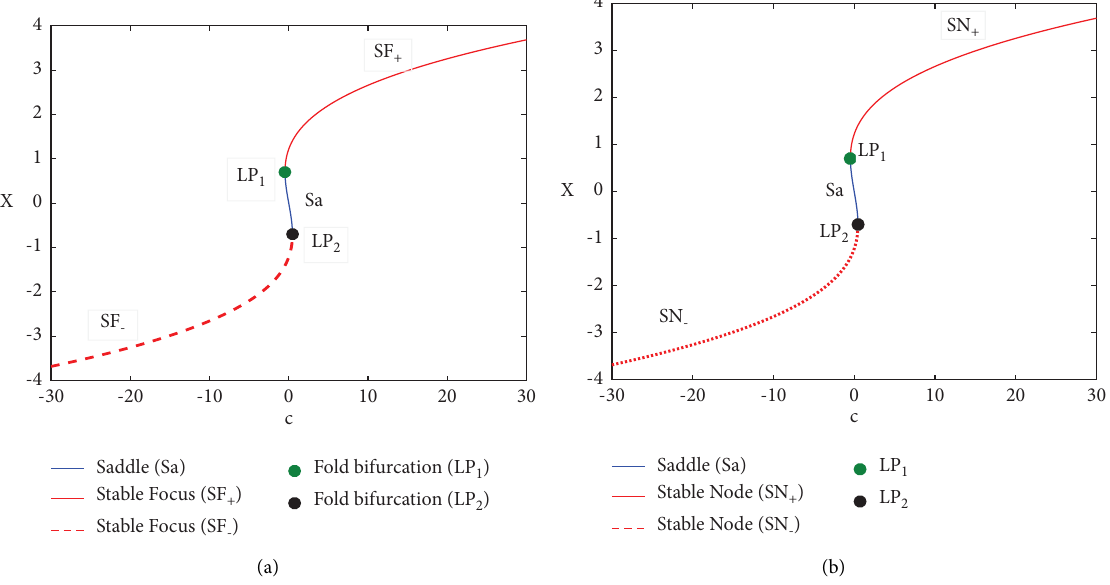
Figure 11: Defection of the plant with respect to c for diferent values of the damping ratio ξ showing the equilibrium points of the plant- wind system for parameters of Figure 7 with (a) ξ � 0 . 5 and (b) ξ � 2 . 5. In these curves, LP